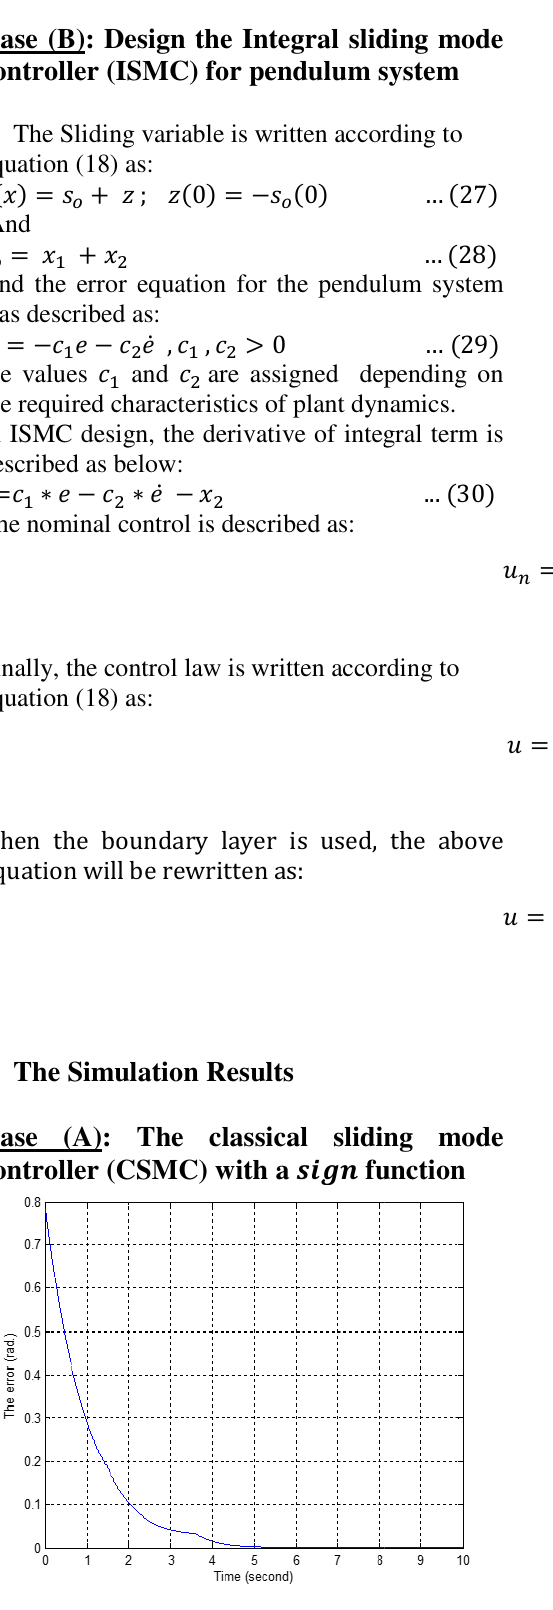
vs. time of the C ‘